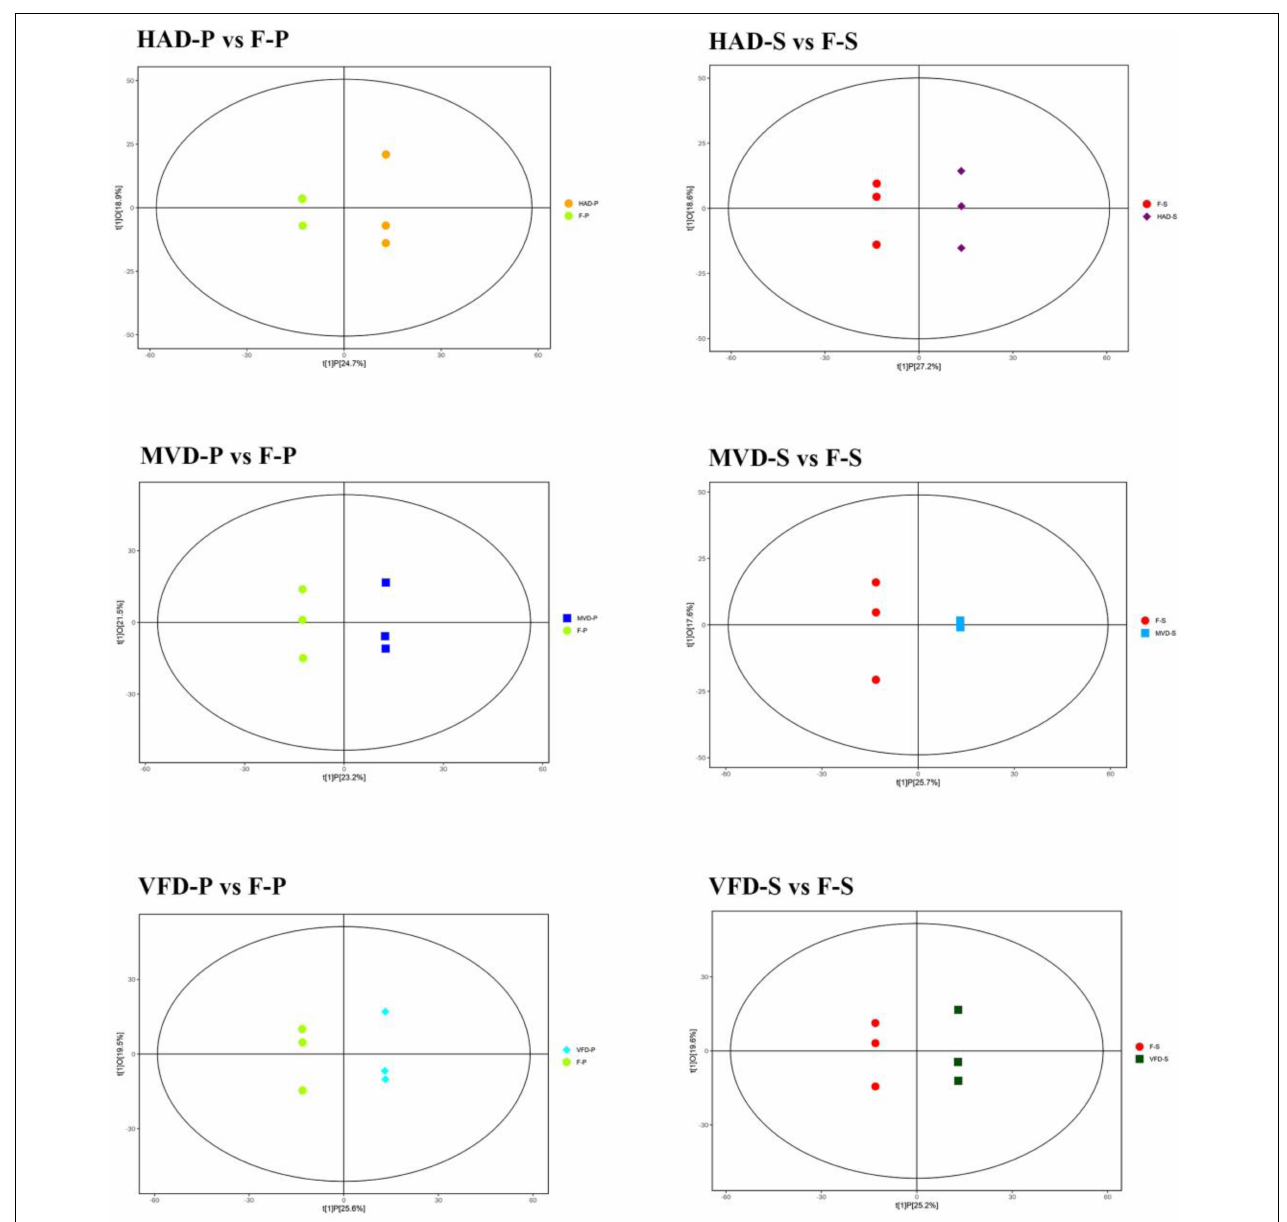
FIGURE 3 | Score scatterplots of the fitted OPLS-DA models to the metabolite data.